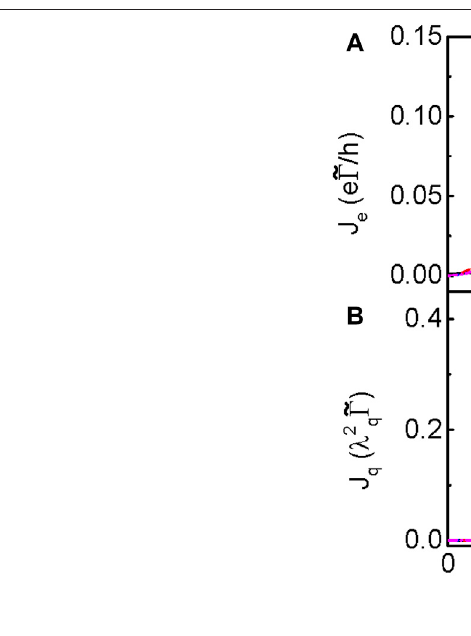
FIGURE 4 | J e in (A) and J q in (B) as functions of the bias voltage when the QD is coupled to MBSs for different values of δ M and fi xed. The Coulomb interaction is ̃ (cid:1) ω chosen at different values with fi xed λ q /4. Other parameters are as in Figure 2 .